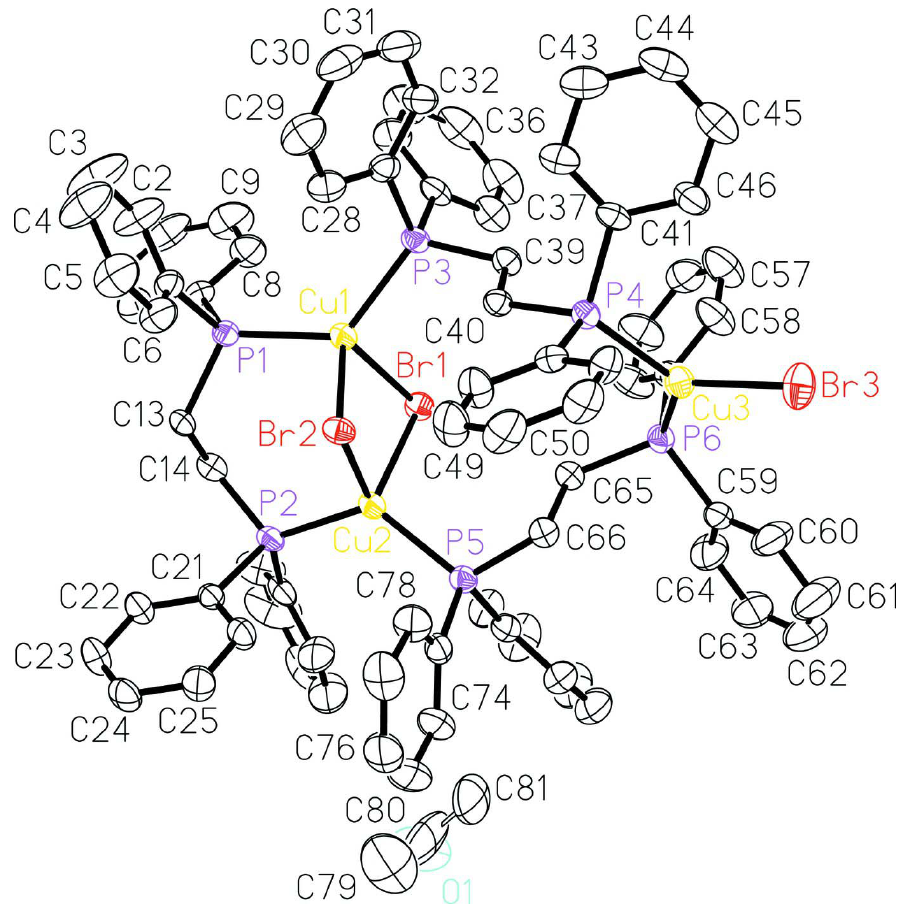
The asymmetric unit of (I), with displacement ellipsoids drawn at the 30% probability level. H atoms are omitted for